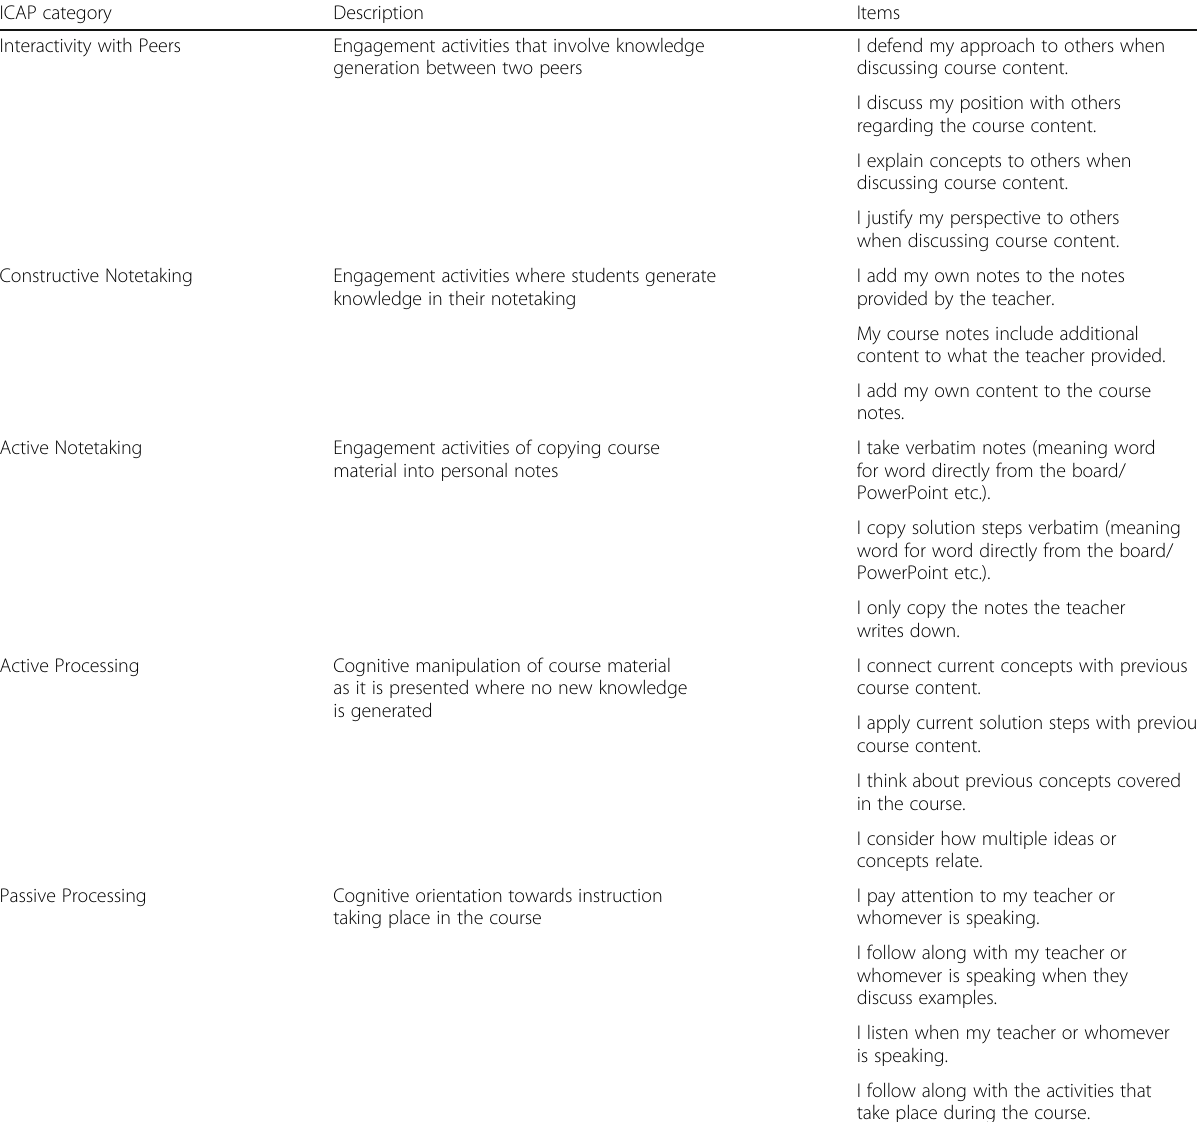
Table 4 The SCCEI used to measure student cognitive engagement ICAP